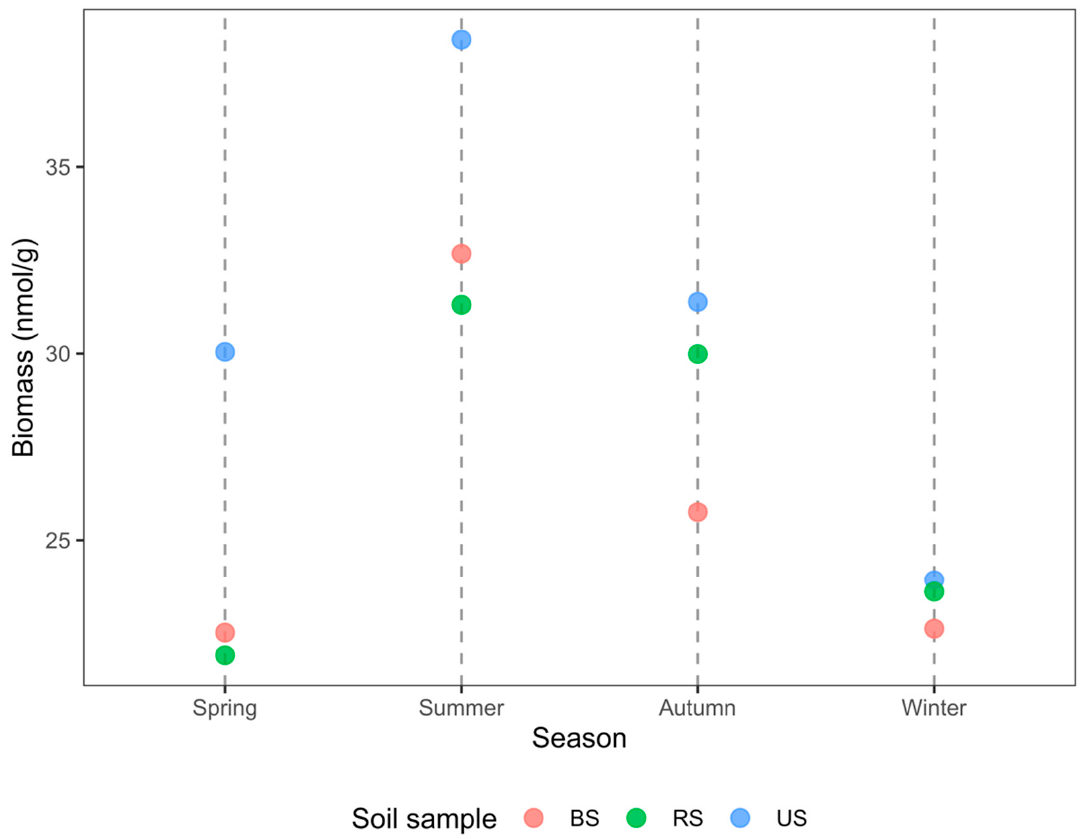
Figure 2. Microbial biomass measured via PLFA analysis in three groups of soil sampled in different seasons. It was consistently highest in uncultivated soil. Abbreviations: BS—bulk soil; RS—rhizosphere soil; US—uncultivated soil.